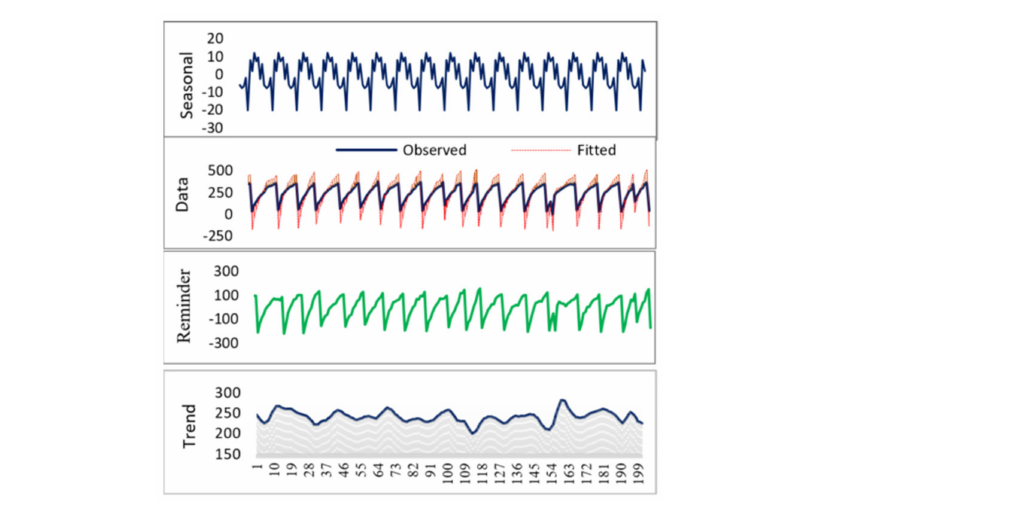
Figure 21. STDL of the capacitor charge level data, when workpiece surface roughness Ra = 4.03.